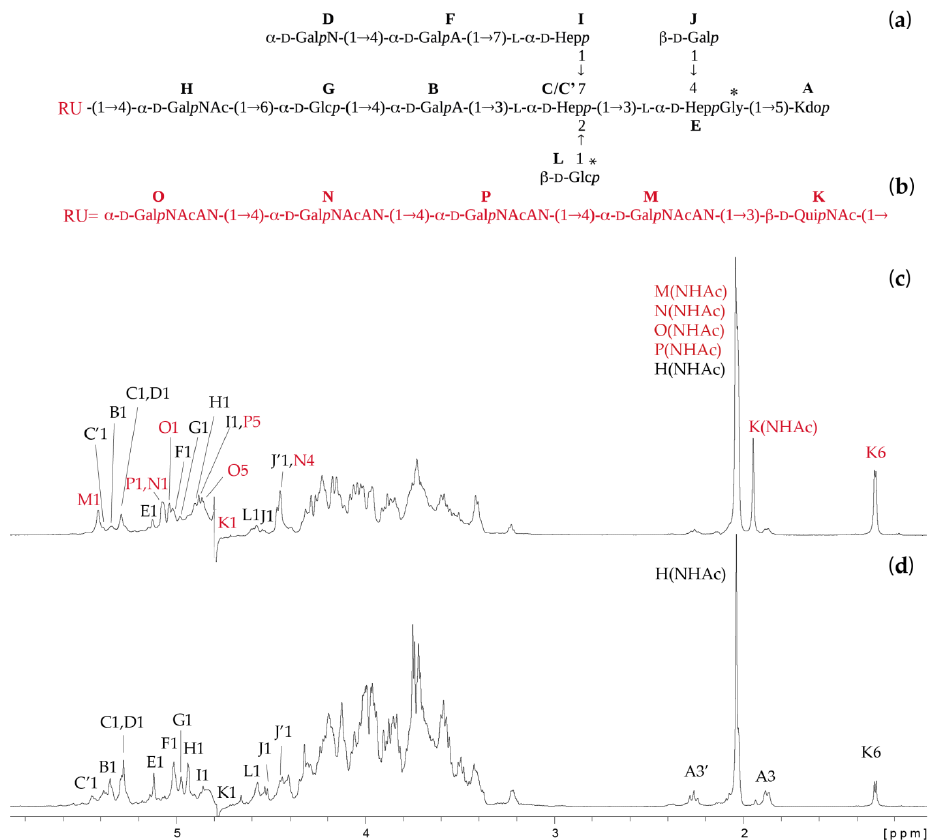
Figure 1. The structures and selected 1 H NMR spectra of poly- and oligosaccharides isolated from P. shigelloides 90/89 LPS. ( a ) The structure of the OS fraction, ( b ) the structure of the first RU (marked in red) of the O-specific polysaccharide linked to the core OS. 1D 1 H NMR spectra of the ( c ) fraction 2—OSRU and ( d ) fraction 3—OS. The symbol * indicates nonstoichiometric substituents. The